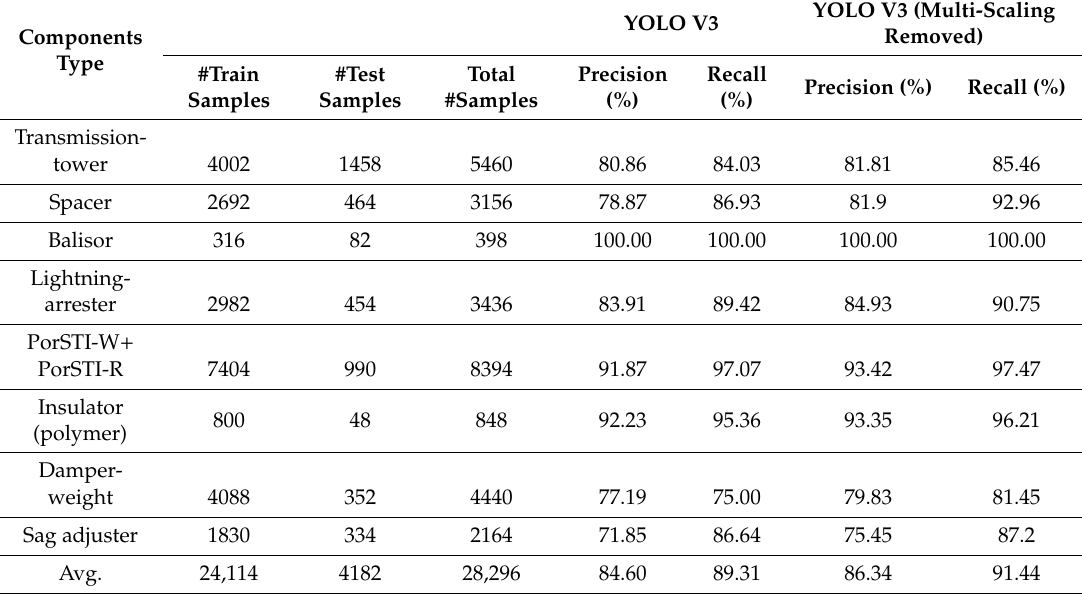
Table 1. Summary of performances of the real-time CNN-based detector embedded on Jetson